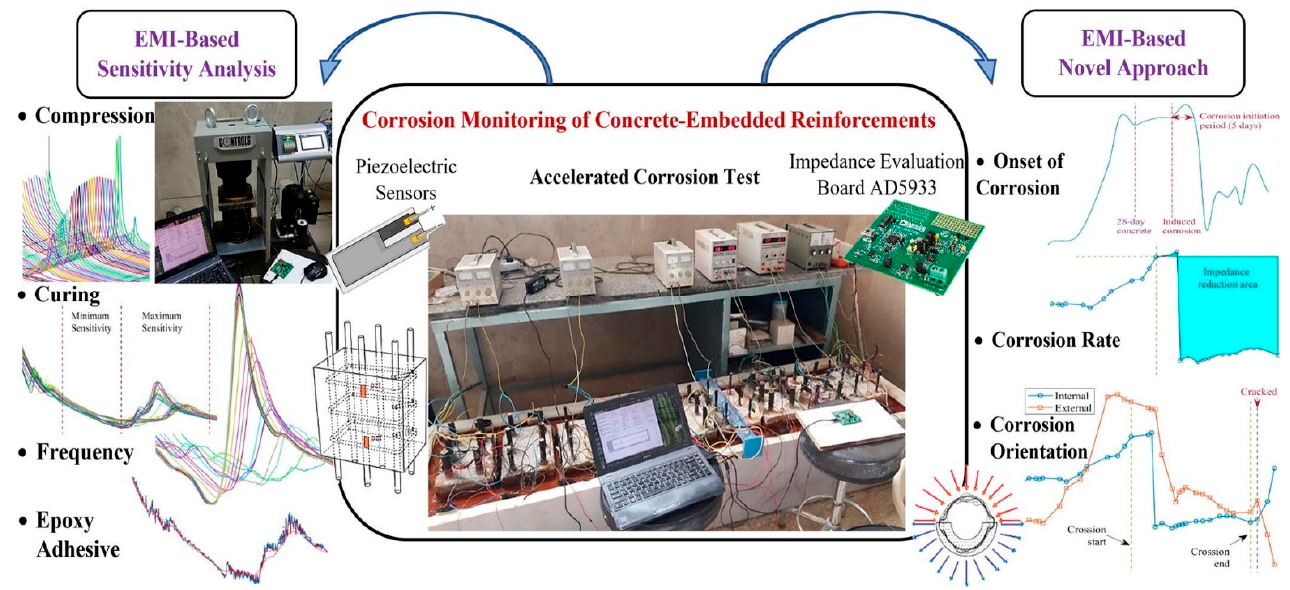
Figure 17. The electromechanical impedance method (EMI) is applied to structural health monitoring and corrosion nondestructive diagnosis [157].